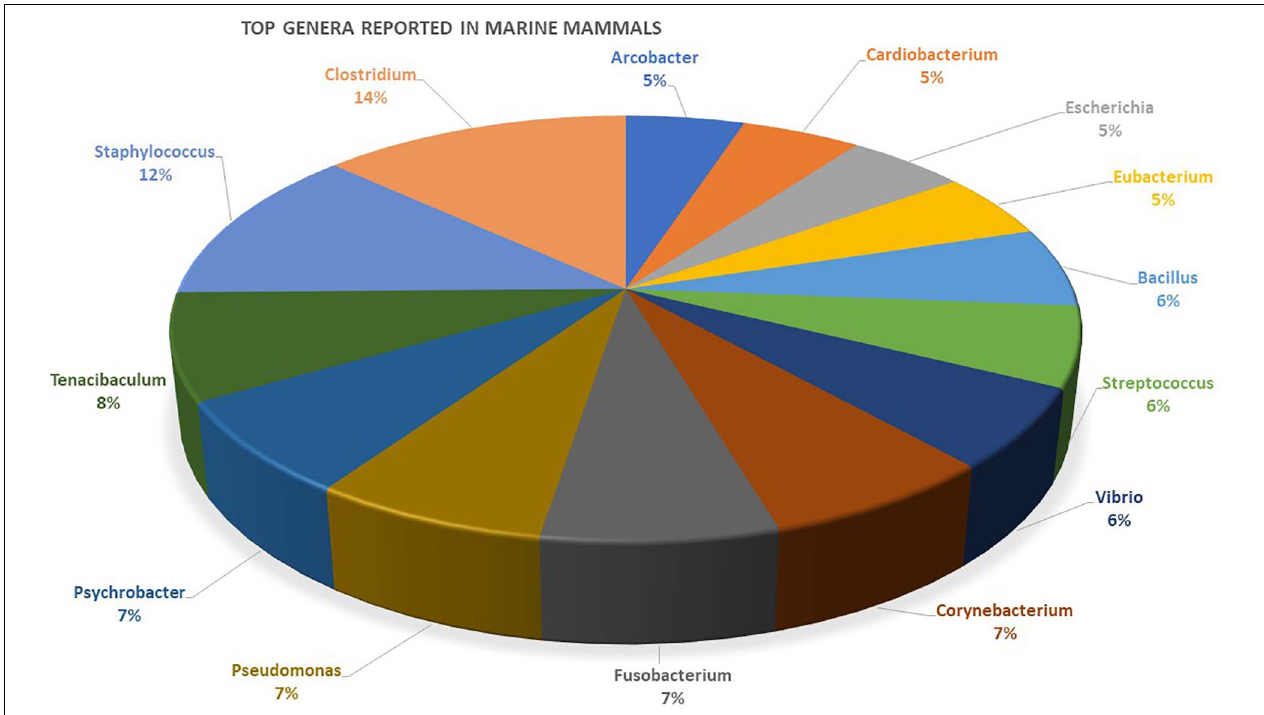
FIGURE 2 | Genera most often reported in primary marine mammal microbiome studies from various tissue-specific niches. A list of the different genera reported in studies and details about the mammal’s host is provided as Supplementary Table 2 .